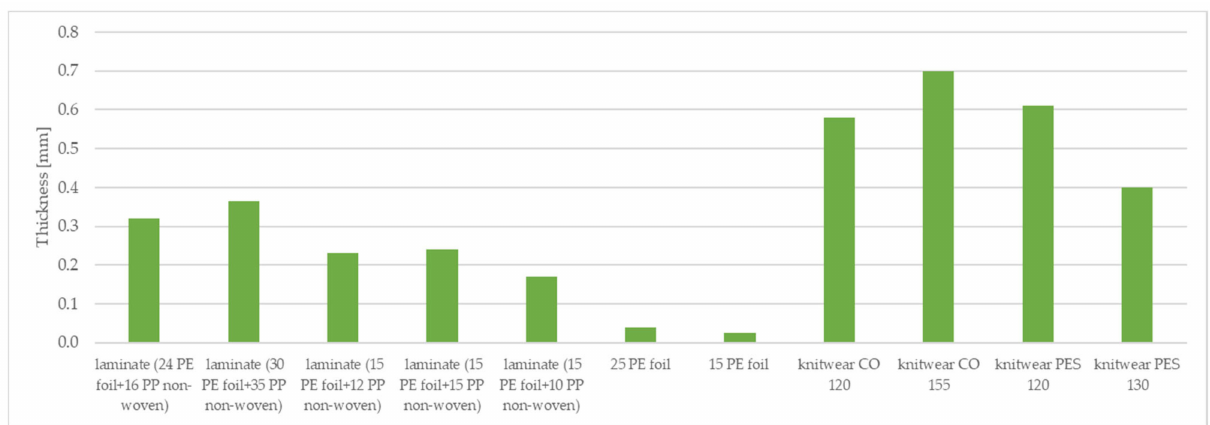
Figure 6. Thickness of tested